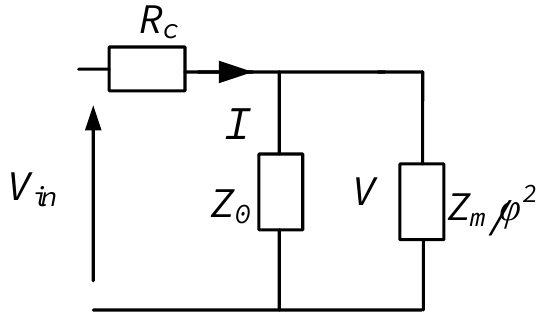
According to the circuit theory, the circuit diagram shown in Figure 5 can be simplified to the circuit diagram shown in Figure 6.